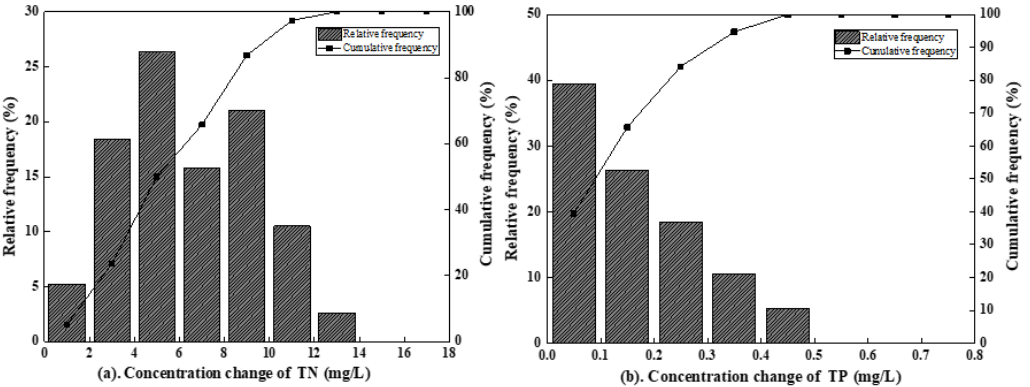
Figure 7. The final concentration of TN and TP (( a ) Concentration change of TN; ( b ) Concentration change of TP).